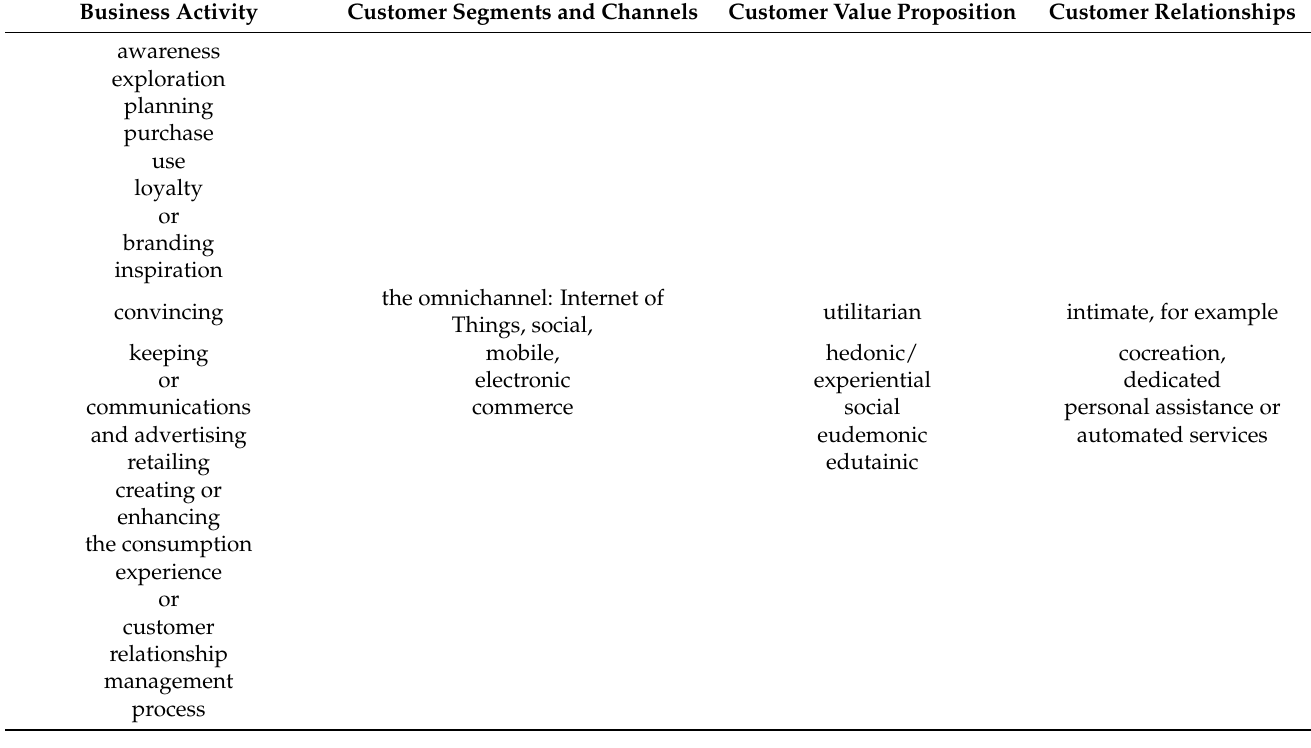
Table 1. ER-based marketing components.